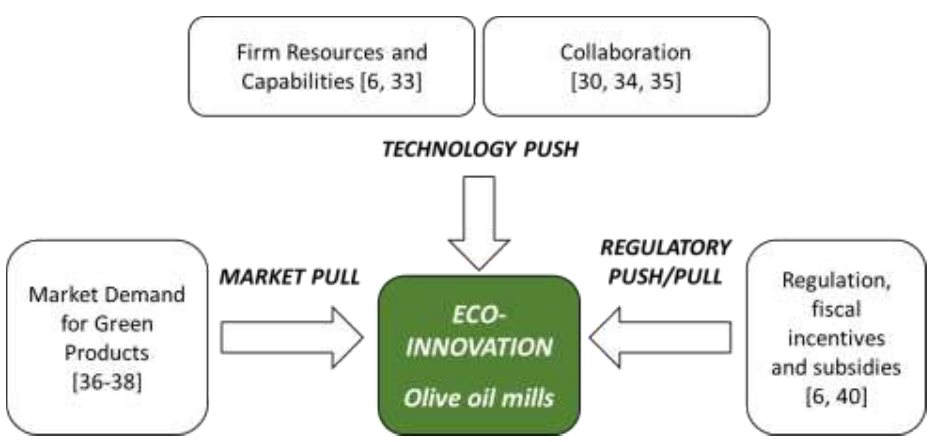
Figure 1. Drivers of eco-innovation. Adapted from Triguero et al. [5] .